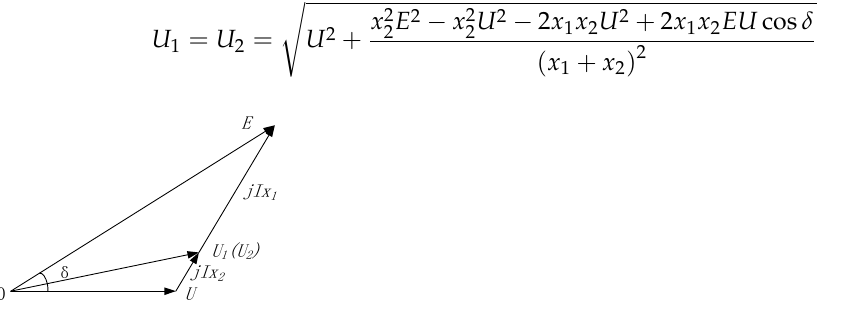
Figure 14. System voltage phasor diagram.